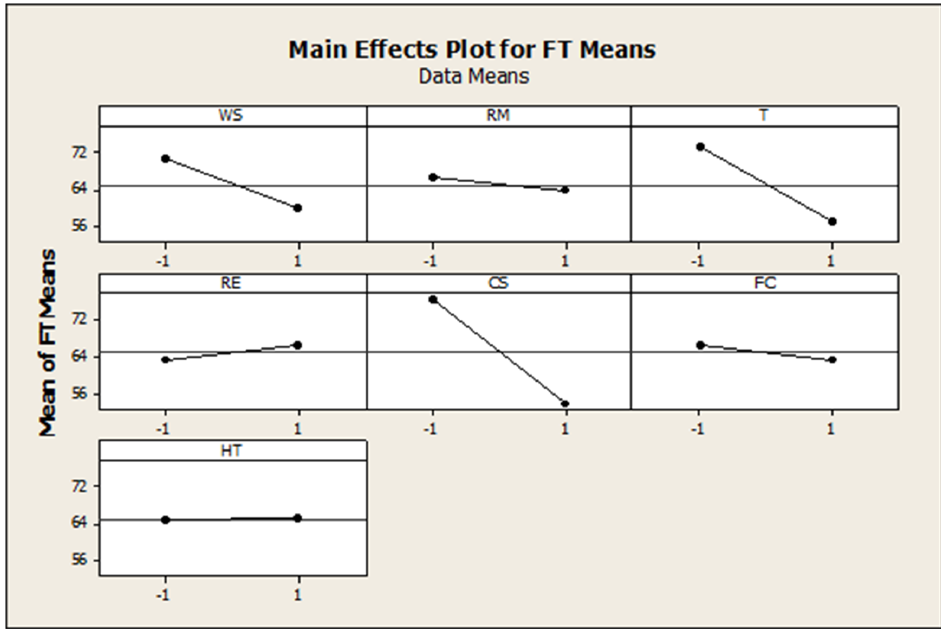
Figure 4. Main effects plot for the means of the filtration time.